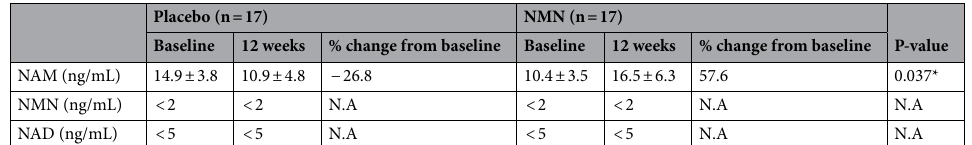
Table 3. NAD + metabolites of the placebo and NMN intake groups before and after the intervention period. Values are presented as mean ± standard deviation. Primary efficacy variables were statistically analyzed using a full-analysis-set population. Analysis of covariance (ANCOVA) was applied for significance between the two groups using the baseline as a covariate. Statistical significance was set at p < 0.05. NAM nicotinamide, NMN nicotinamide mononucleotide, NAD nicotinamide adenine dinucleotide.